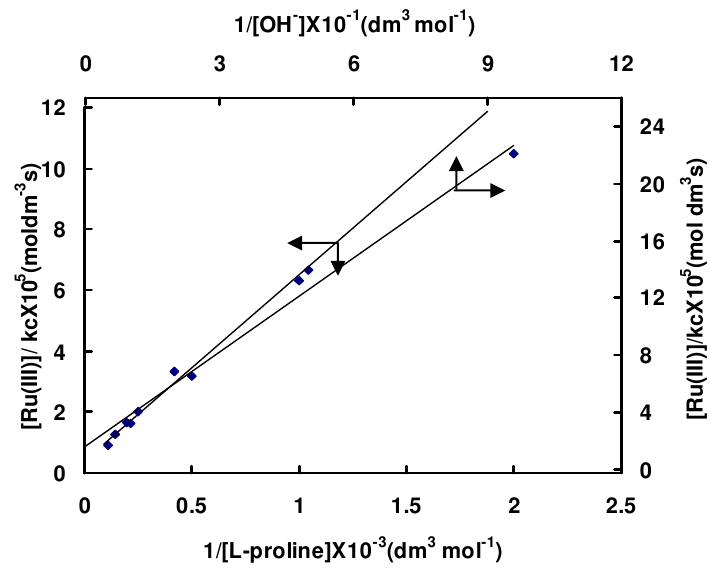
Figure 3. Plot of [Ru(III)]/ k obs vs 1/[ L-Proline] and [Ru(III)]/ k obs vs 1/[OH - ] (conditions as in Table 1).